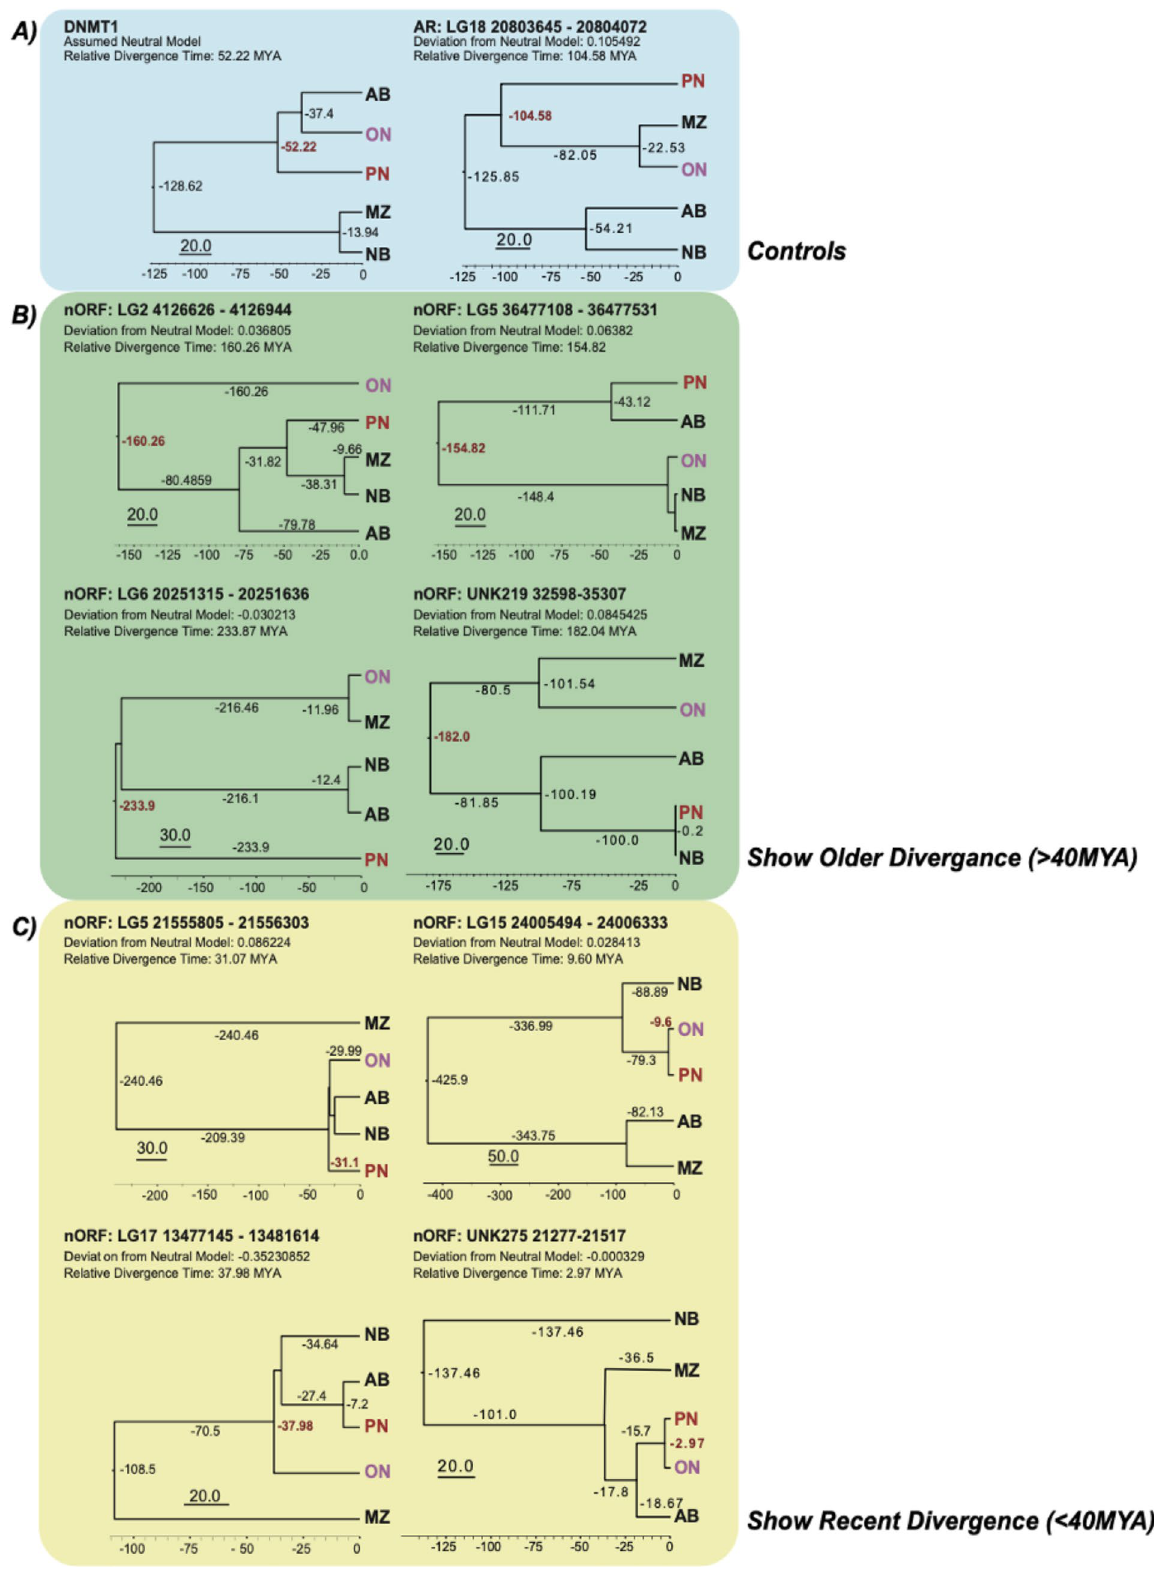
Figure 5. Phylogenetic trees based on nORF sequences that were time-calibrated using fossil priors and substitution rate. These trees were constructed using BEAST v1.10.4. The DNMT1 gene and AR (ancestral repeat) were used as controls. The nORF’s selected had been shown to deviate from the Neutral Model. For each tree we show the degree of deviation from the Neutral Model, along with the relative divergence time between PNi and ON, that was calculated based on that particular sequence and deviation from the Neutral Model (which was set at 1). ( A ) DNMT1 and ancestral repeat sequence divergence used as controls. ( B ) Four nORFs that showed divergence prior to 40 MYA. ( C ) Four nORFs that showed divergence earlier than 40